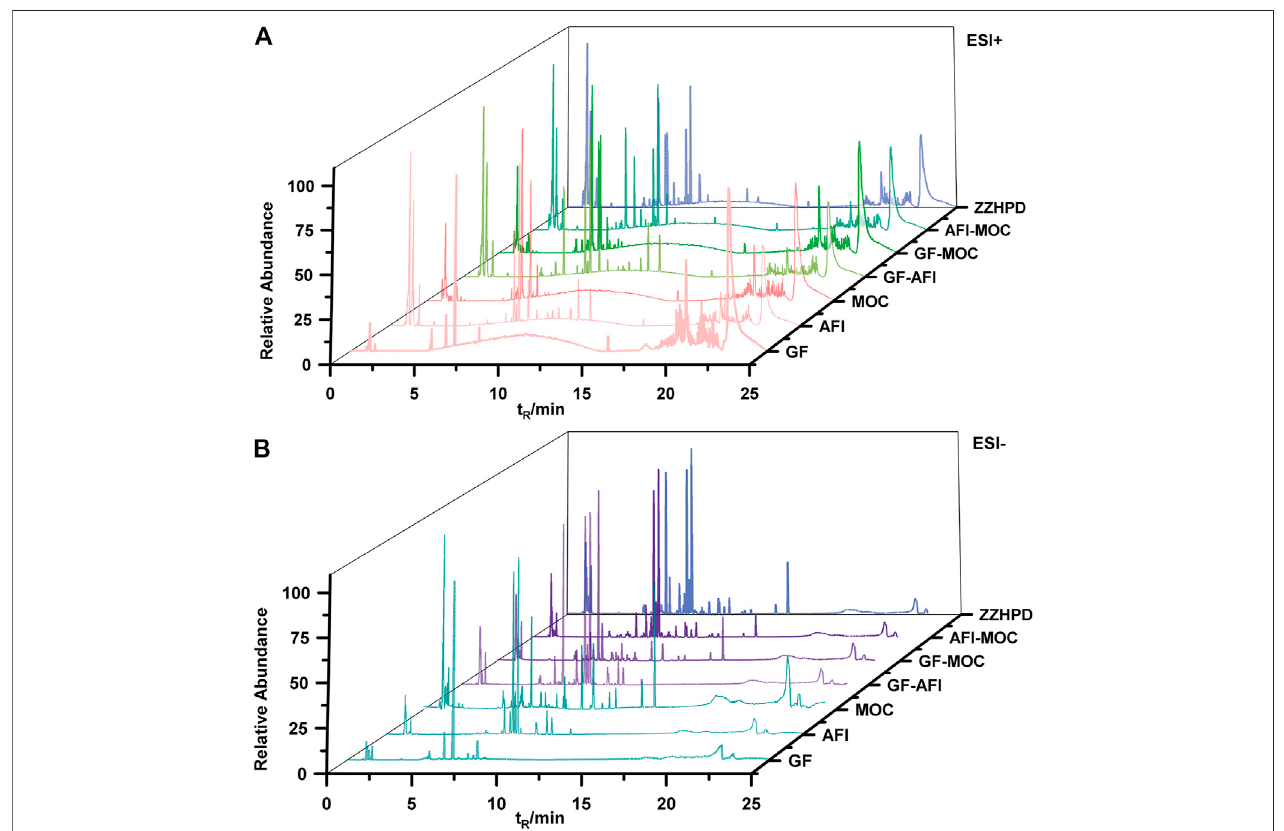
FIGURE 2 | Typical BPI of GF, AFI, MOC and co-decoction under the positive ion mode ( A ) and negative ion mode ( B ).